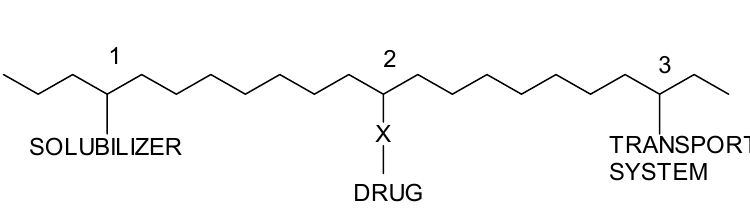
Figure 1 . Ringsdorf model of synthetic polymer